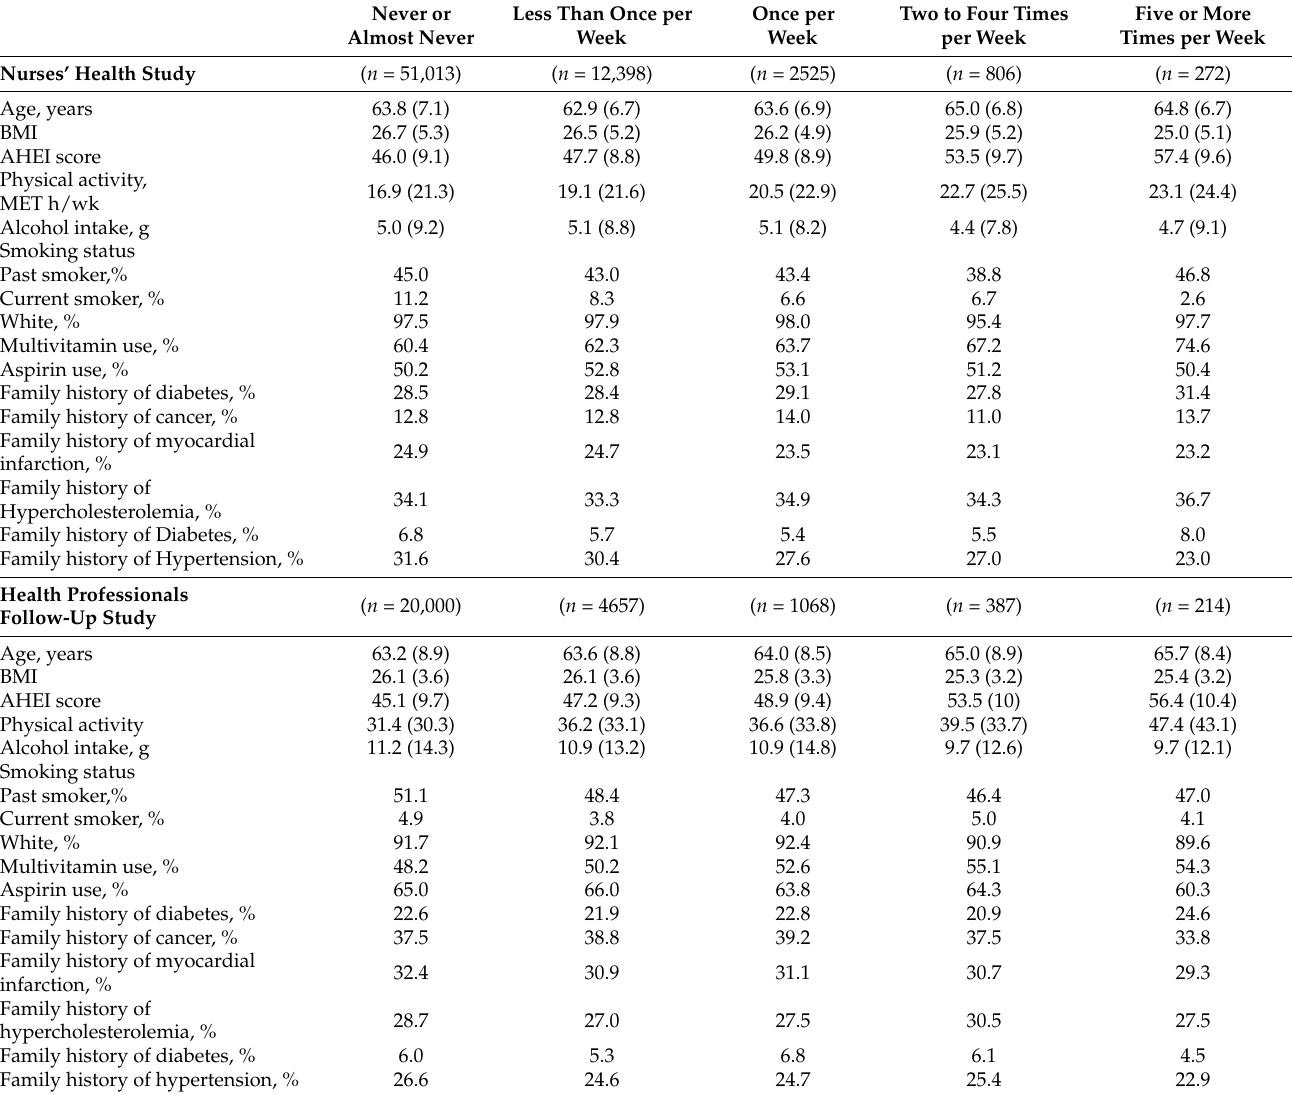
Table 1. Baseline characteristics according to frequency of walnut consumption. Never or Less Than Once per Almost Never Week